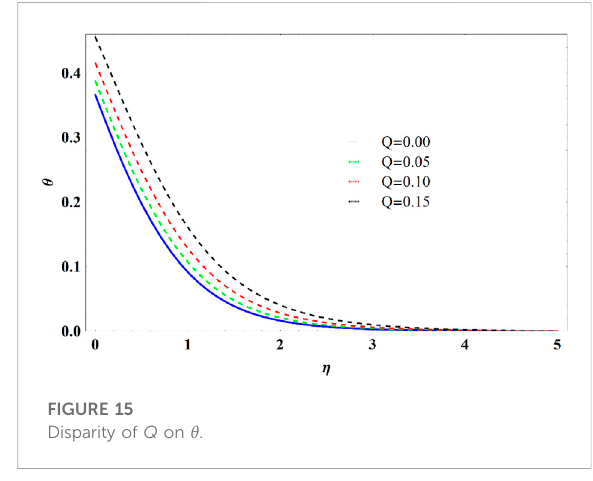
FIGURE 12 Disparity of δ on ϕ .